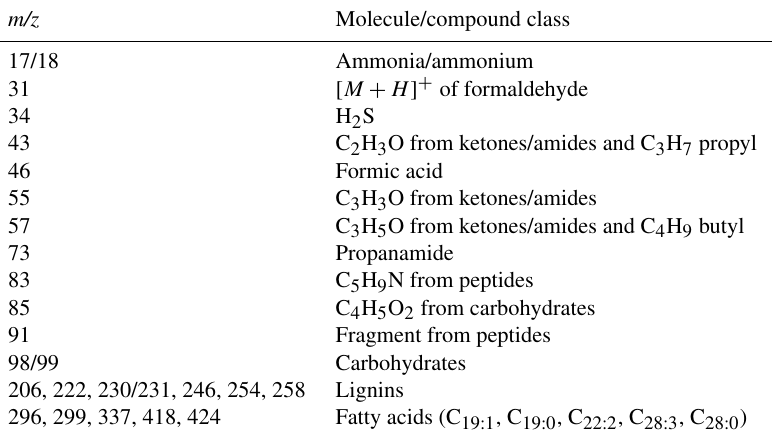
Table 3. Results of iterative partial least-squares regression for cumulated CO 2 efflux as an dependent variable and m/z data of all treatments and sampling times as explaining variables.